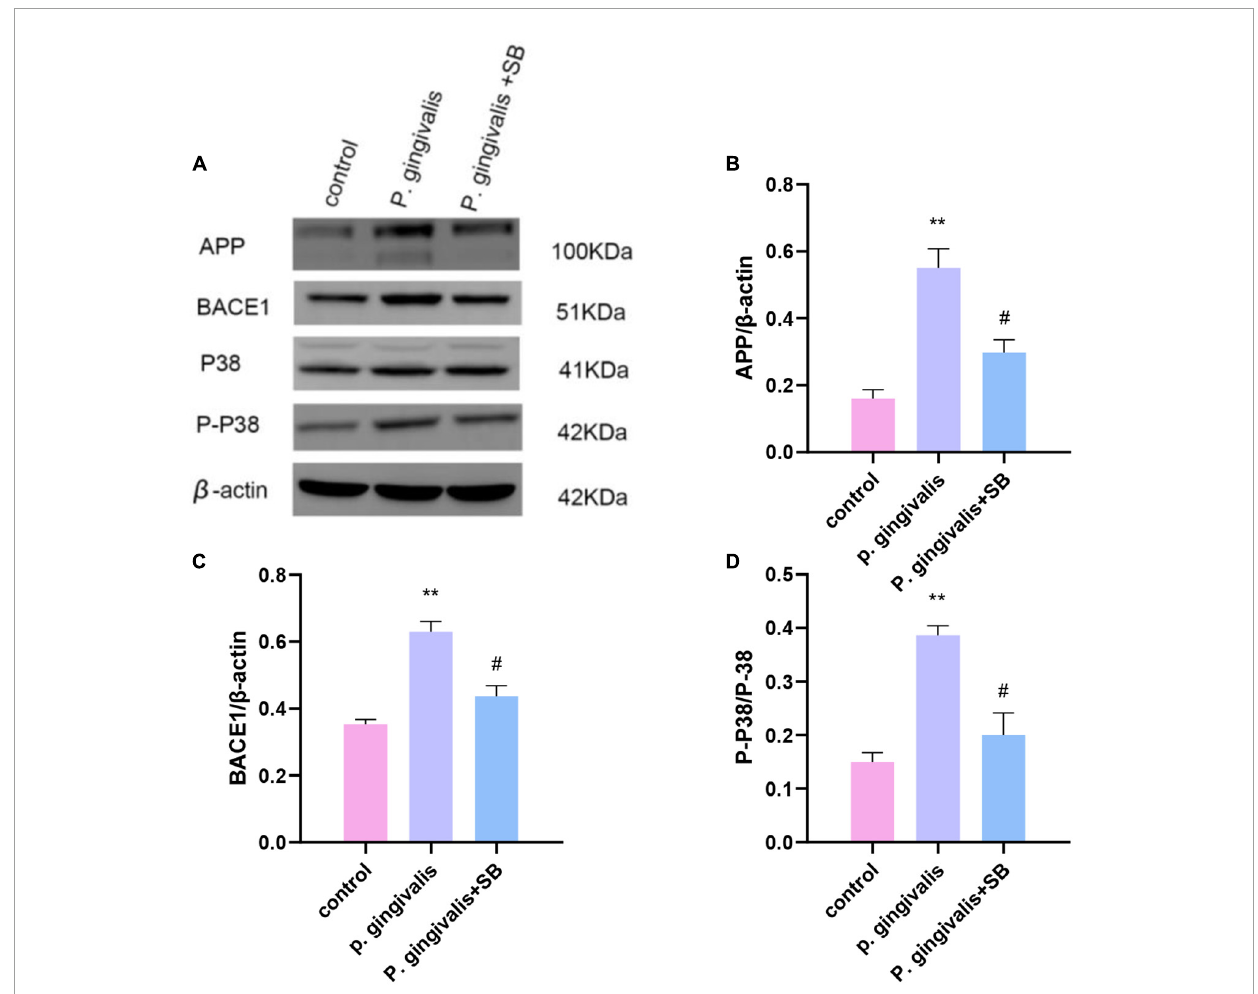
FIGURE10 Effects of periodontitis on the protein level of APP and the activation of the P38 MAPK signaling pathway. (A) All of the above proteins were upregulated by P. gingivalis (except protein P38). High expression of these proteins was effectively inhibited by SB203580. (B–D) The quantification of related protein expression in each group. Experimental values are expressed as the mean ± SEM ( n = 3 per group). ** p < 0.01 compared with the control group, # p < 0.05 compared with the P. gingivalis